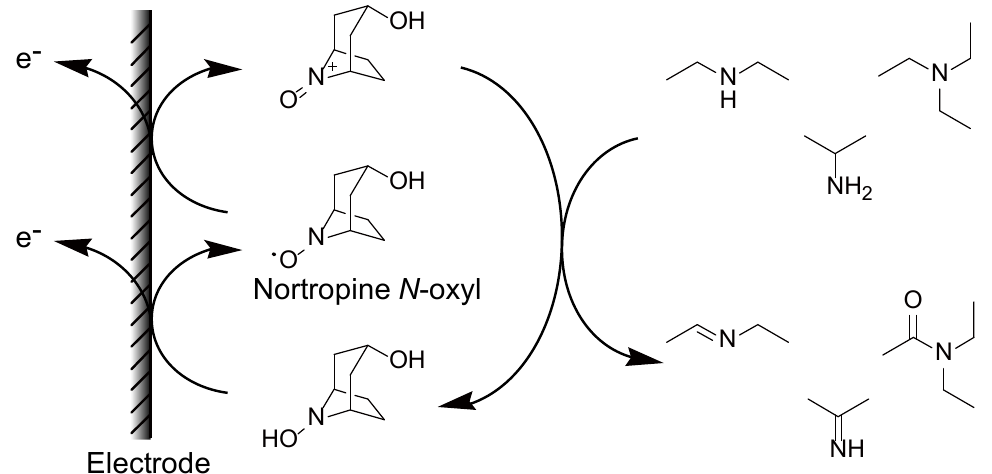
Figure 1. Electrochemical reactions of nortropine N -oxyl (NNO) for secondary amines, tertiary amines, and isopropylamine.